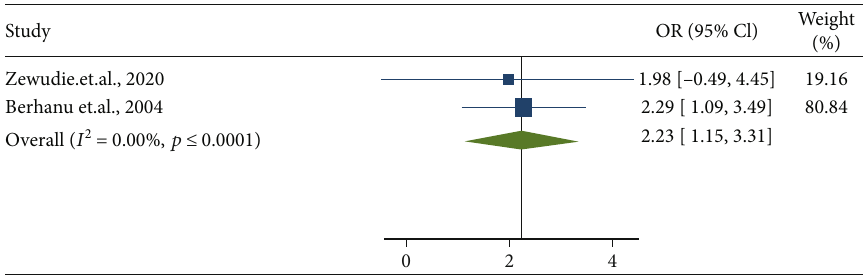
Figure 7: Forest plot depicting pooled random-e ff ect size (OR) of seizure frequency before treatment.